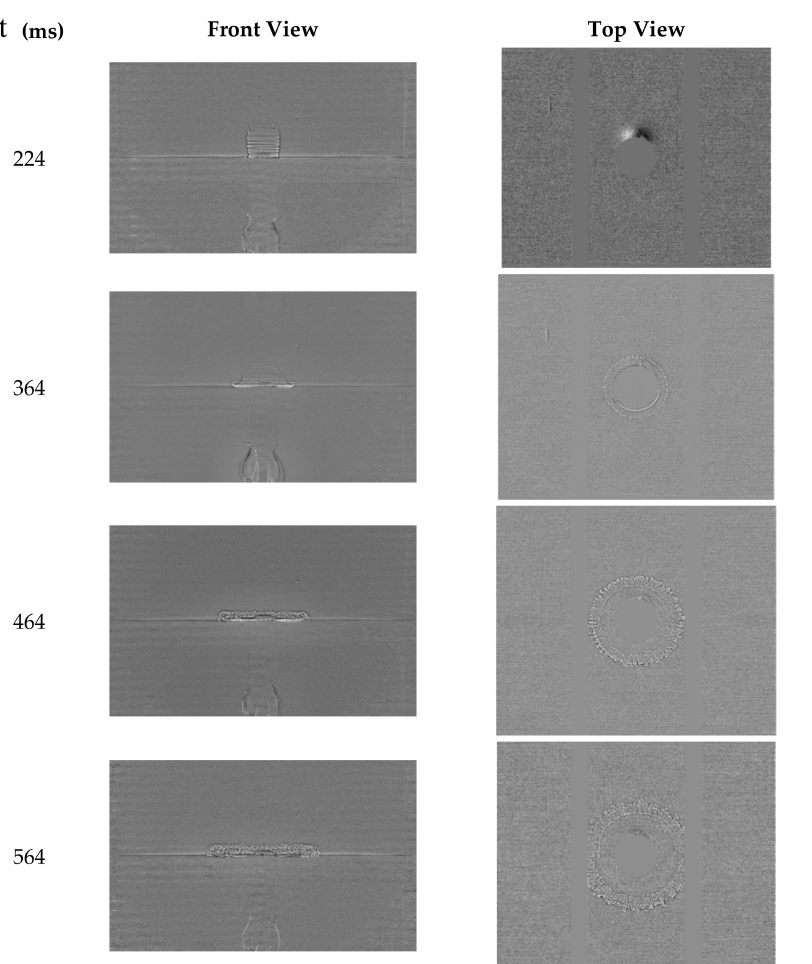
Figure 6. Shadowgraphs (front view and top view) of trial 15E showing the evolution of the krypton cloud. For each row, the front and top view pictures are taken at the same time. The origin of time corresponds to the beginning of the descent of the container.